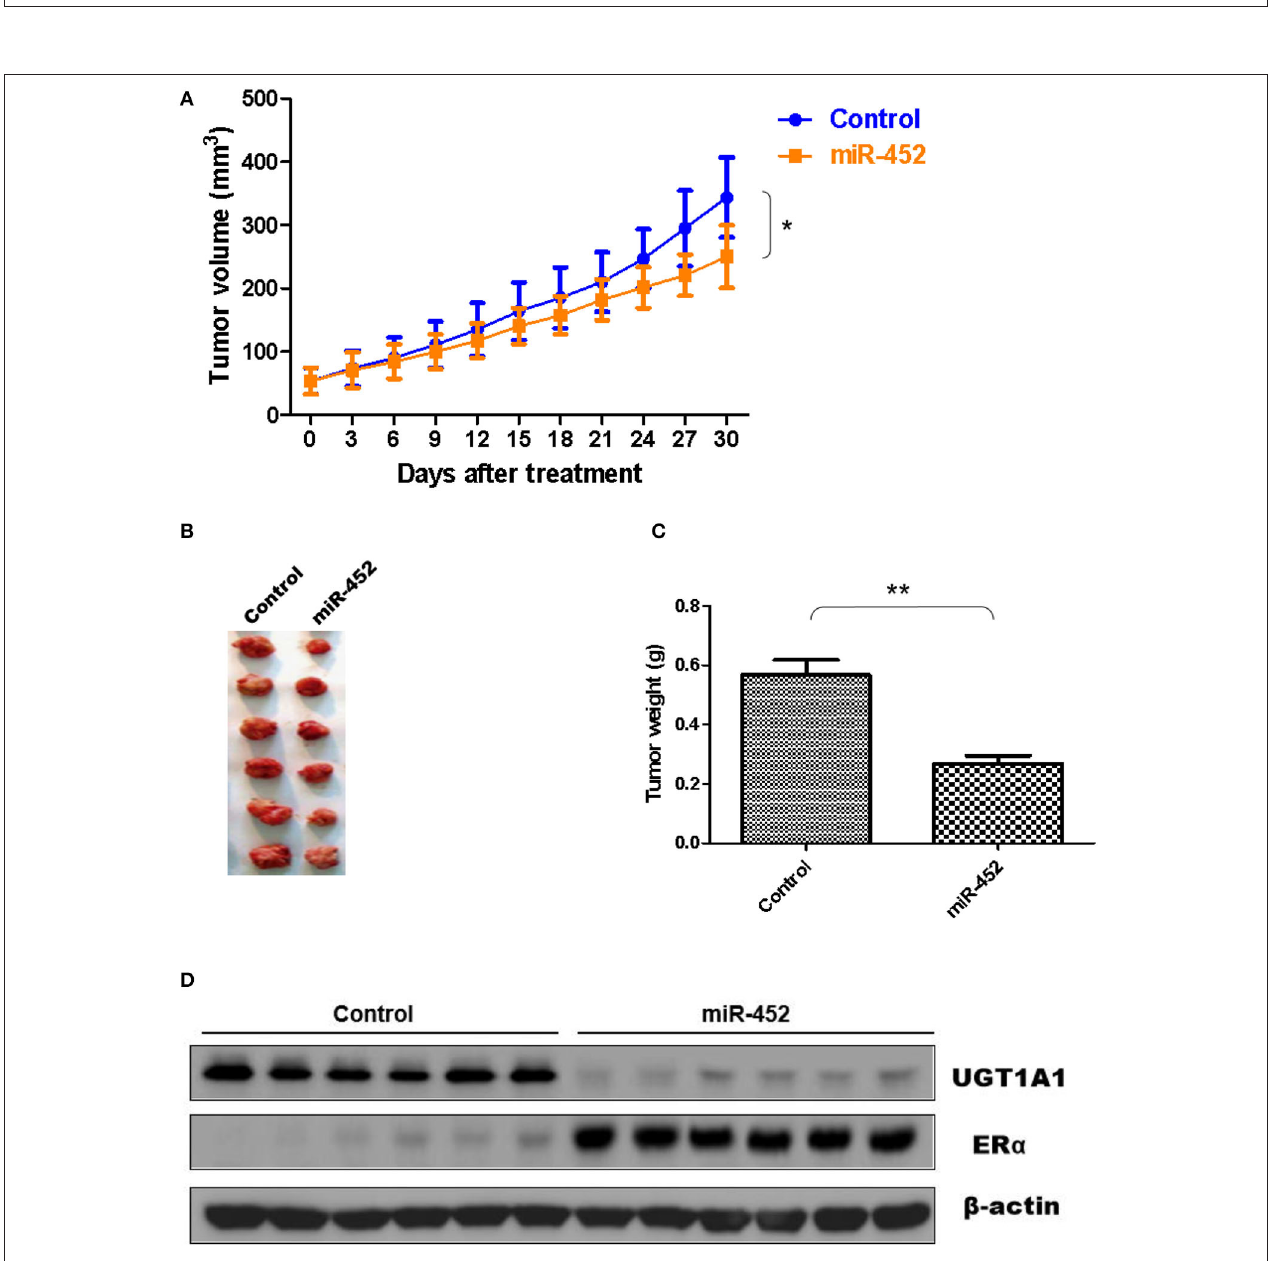
FIGURE 9 | miR-452 antagomir suppressed TNBC xenograft. To detect anti-tumor activity induced by miR-452 antagomir in vivo , human TNBC xenografts were established with MDA-MB-231 cell line. The xenografts of control groups grew rapidly, but in the experiment group, which was treated with antagomir of miR-452, they grew slowly in vivo (A) . Moreover, the weight of tumors in the experiment mice (treated with antagomir of miR-452) was significantly less than that of the control group (B,C) . At the time of end, the average tumor volume of control mice was much larger than that of the experiment group, and the difference between the two groups had statistical significance (C) . As we can see, the results revealed that compared with the control group, treatment with antagomir of miR-452 downregulated the expression of UGT1A1 with statistical significance and promoted protein expression of ER α in xenografts (D) . * P < 0.05, ** P < 0.01.